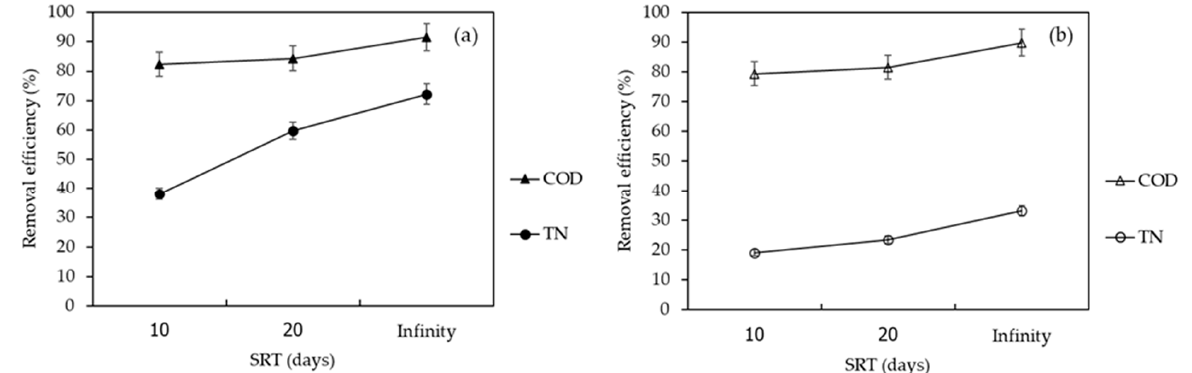
Figure 5. COD and TN removal efficiency at different SRTs in ( a ) the A/O-MBR system (System 1) and ( b ) the O-MBR system (System 2).